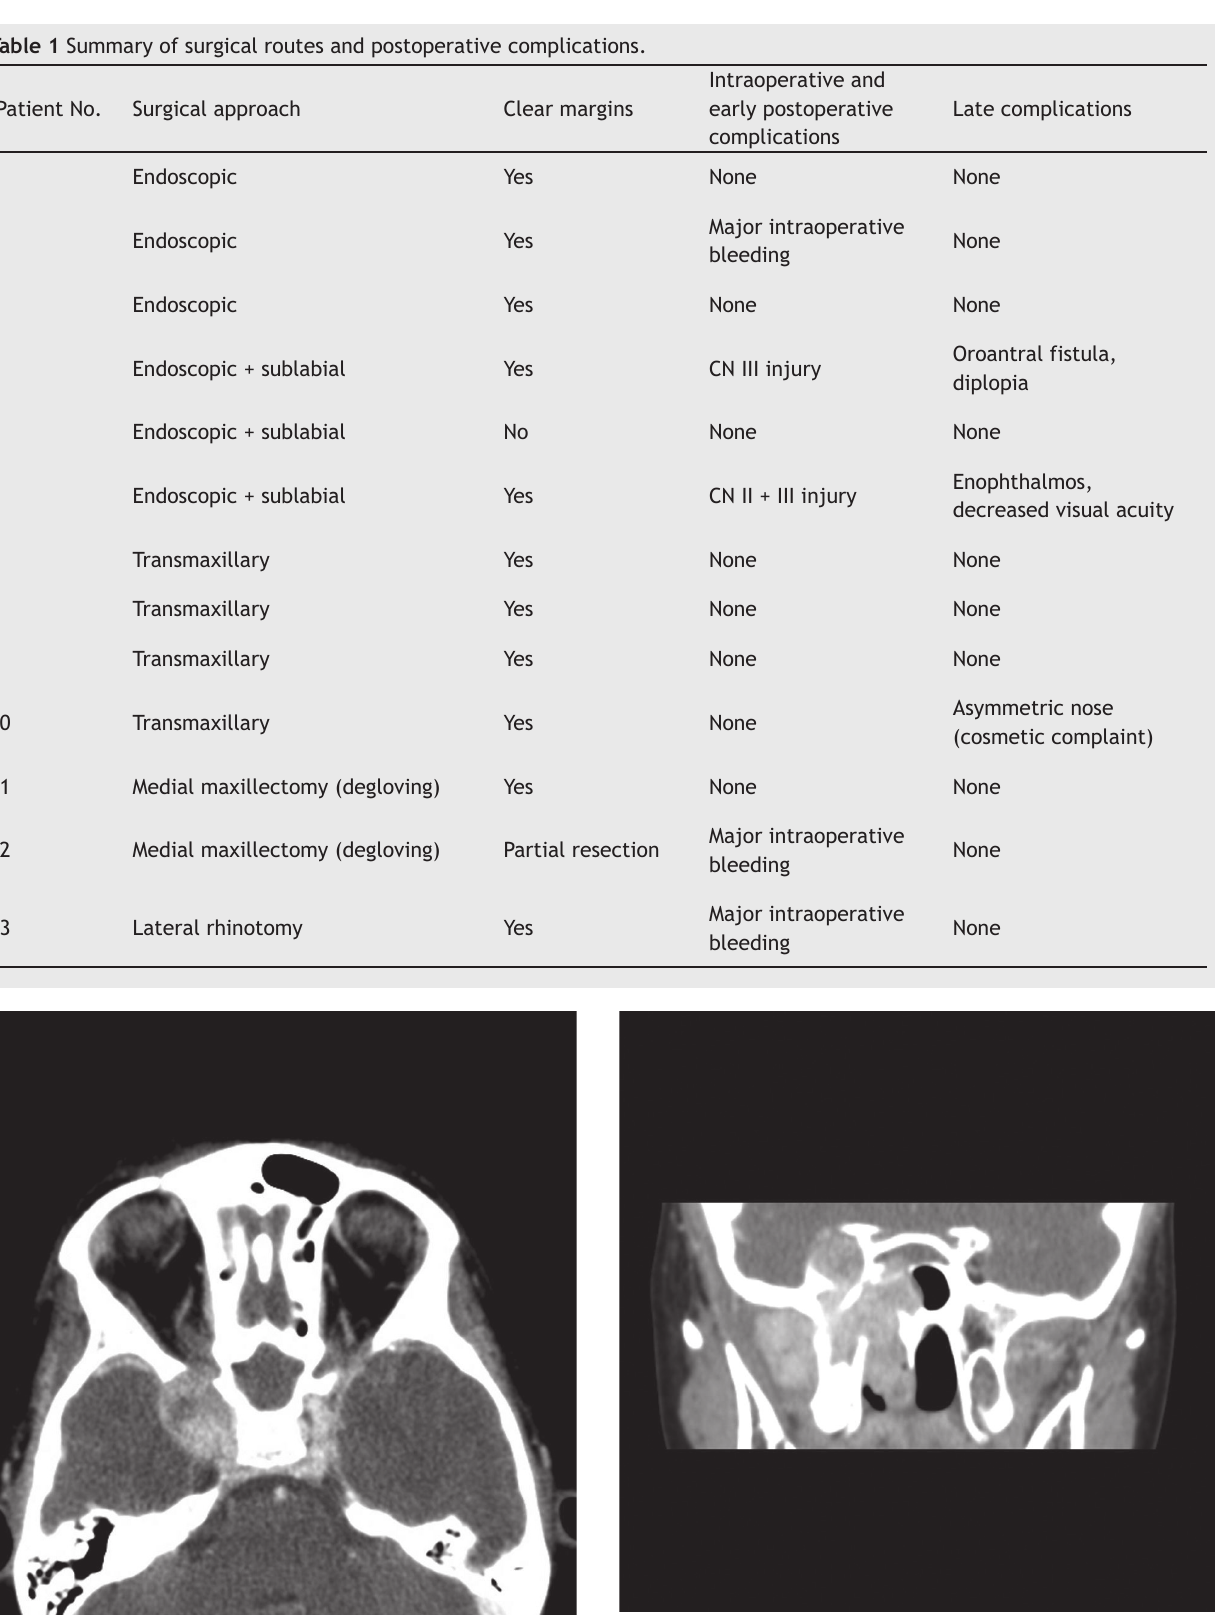
Figure 2 Computed tomography scan (coronal view) of an extensive juvenile angiofibroma. The patient underwent en - doscopic-assisted surgery.